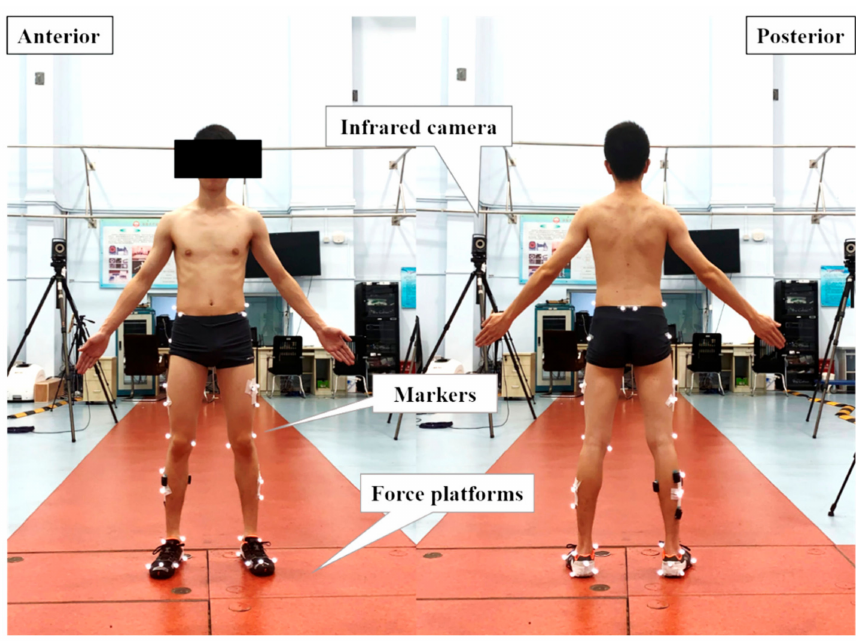
Figure 2. The marker-set and the experimental setup.